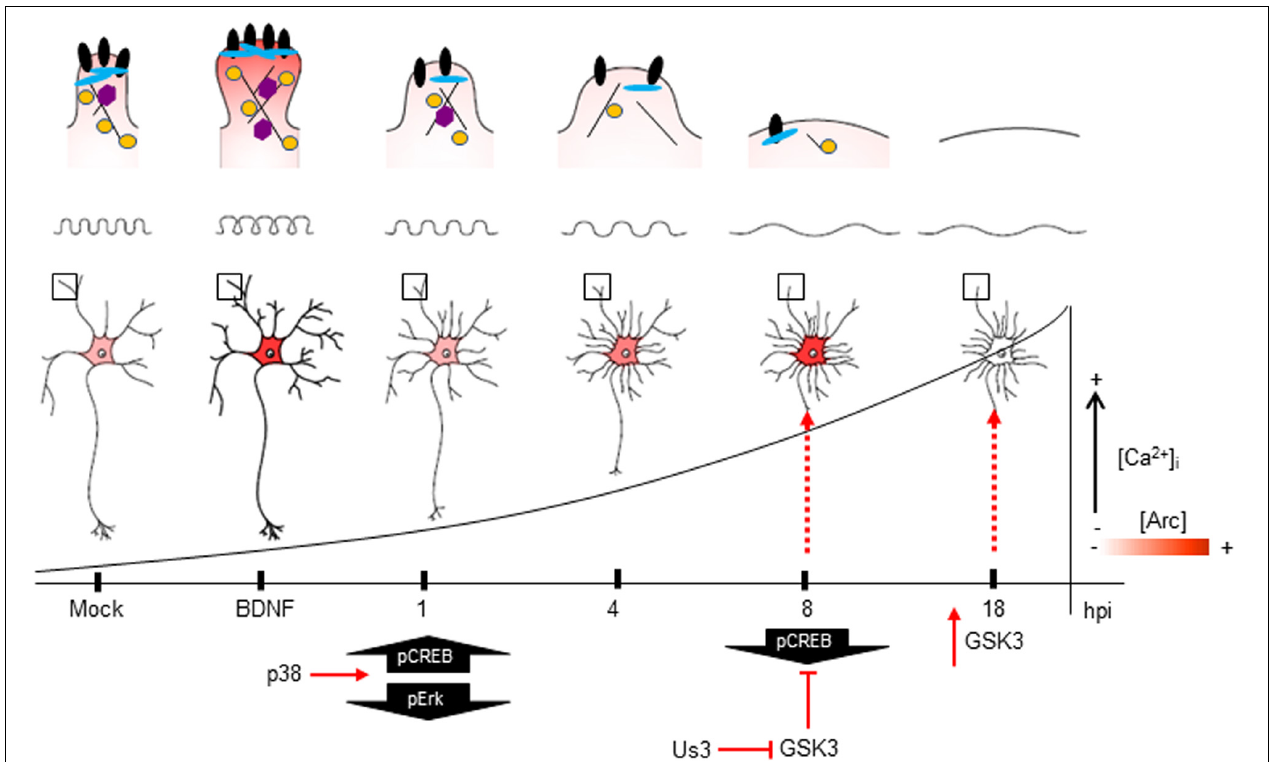
FIGURE 9 | The impact of HSV-1 neuronal infection at the dendritic spine level. Diagram of the HSV-1-induced phenotype in cortical neurons at 1, 4, 8 and 18 hpi. Changes in shape and structure both in somata and dendrites are shown. Early in infection, 1 hpi CREB is activated (pS133) by p38 MAPK (Hargett et al., 2005) instead of Erk. From 1 hpi there is a progressive decrease of PSD-95, Drebrin and CaMKII β along the infection kinetics (upper panel zoom dendrites), most likely due to VHS viral protein in charge of downregulating the host cell mRNAs (Brunella Taddeo et al., 2007). From 4 hpi there is a notorious increase of Arc expression (shown as red color), reaching its highest level at 8 hpi. At this time, CREB activation is downregulated, most likely due to the inhibitory phosphorylation of GSK3 at S129. The viral kinase Us3 phosphorylates GSK3 at inhibitory residue (S9) (Wagner and Smiley, 2009), thus promoting Arc accumulation (Gozdz et al., 2017) (first dashed red arrow). Then, at 18 hpi, the Us3 effect is abolished and GSK3 is activated due to the rising levels of intracellular calcium (Piacentini et al., 2011). The activation of GSK3 promotes Arc degradation at late infection (18 hpi) (second dashed red arrow), this rapid turnover of Arc expression is accompanied by high S206 phosphorylation levels, which could have an impact on protein